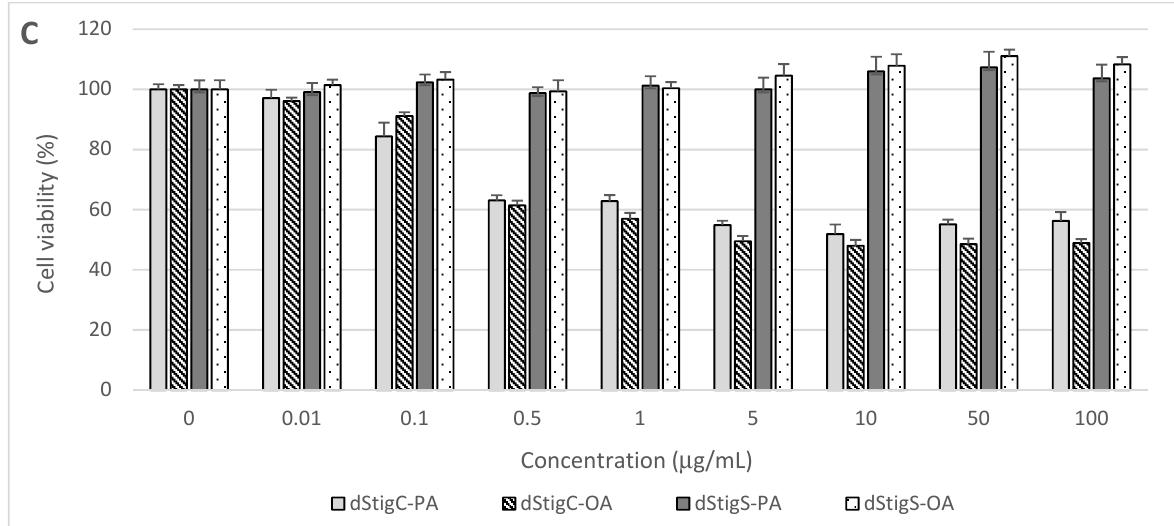
Figure 6. Effect of dStigMAs on ( A ) normal small intestinal epithelial cells (FHs 74 Int, ATCC ® CCL241™), ( B ) normal colonic epithelial cells (CCD 841CoN, ATCC ® CRL-179™), and ( C ) normal liver cells (THLE-2, ATCC ® CRL-2706™).